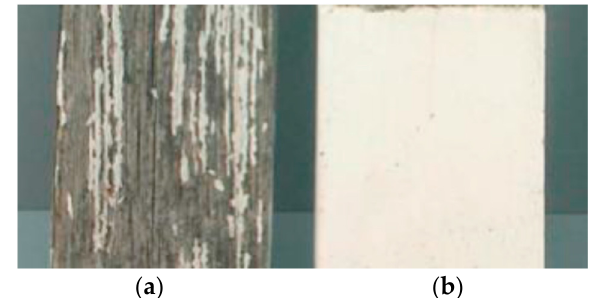
( b ) Figure 11. Control (larch, ( a )) and acetylated (pine, ( b )) samples after 7 years. The control larch (Figure 12a) and western red cedar (Figure 12c) have swollen and the coating has failed close to the end grain. The nails also show some degradation. The western red cedar shows coating detachment and board splitting in several places. The acetylated sample (Figure 12b) shows much less end grain moisture penetration, no swelling and no nail degradation. ( a ) ( b ) ( c ) Figure 12. ( a ) Control larch, ( b ) acetylated pine, and ( c ) western red cedar after 7 years of outdoor testing. In another study [11], acetylated Scots pine ( Pinus sylvestris ) panels with white, black and translucent alkyd and acrylic coatings were exposed outdoors in the Netherlands. The coating (primer system) was applied in 2 layers by spray application to a total dry film thickness of circa 80– 100 μ m. After 9.5 years of exposure it was concluded that the intrinsic quality of the coating itself has become the main factor affecting the durability of coatings on acetylated wood. With an acrylic opaque white coating the condition of the coating after 9.5 years without any maintenance was